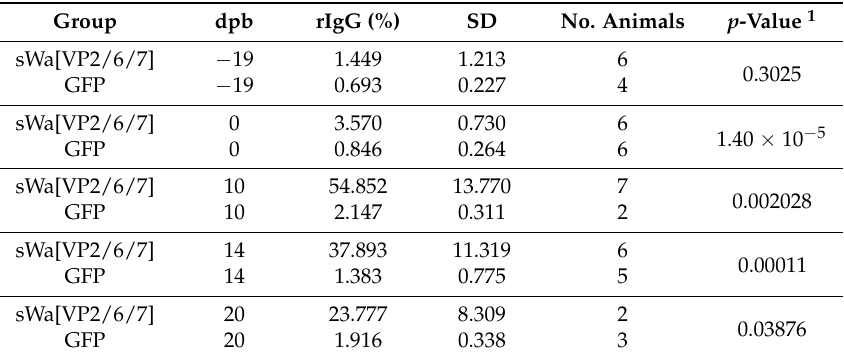
Figure A1. Analysis of guinea pig anti-RV serum specificity. Western blot analysis of whole HepG2 cell lysates from sWa[VP2/6/7] or GFP amplicon vector transduced (MOI 2) or non-transduced mock cells. Proteins were analyzed using the guinea pig polyclonal anti-RV antibody (upper panel); anti-actin antibody (middle panel); or the anti-GFP antibody (lower panel). Expected migration lengths of the RV proteins VP2 and VP6, actin and GFP are indicated on the left with arrows and the positions of the molecular weight markers are shown on the right in kDa. Table A1. This table shows all data used to generate Figure 3B as well as the number of animals included in this study and the p -values.